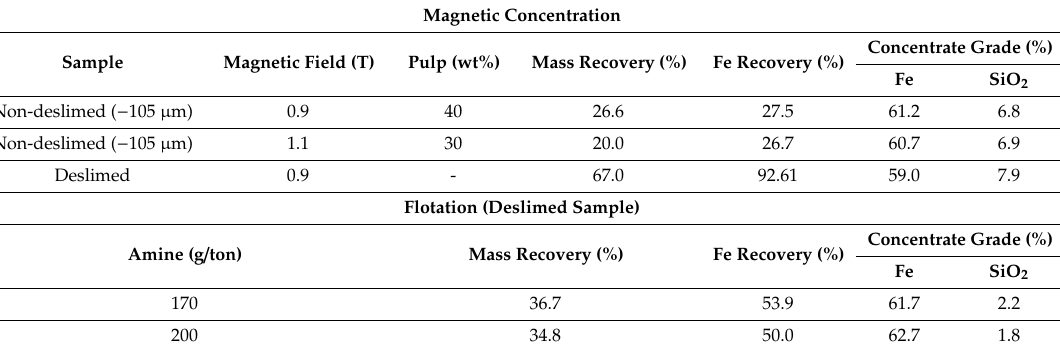
Table 5. Results of the concentration tests carried out with the non-deslimed and deslimed samples of amphibolitic itabirite ( − 105 µ m).